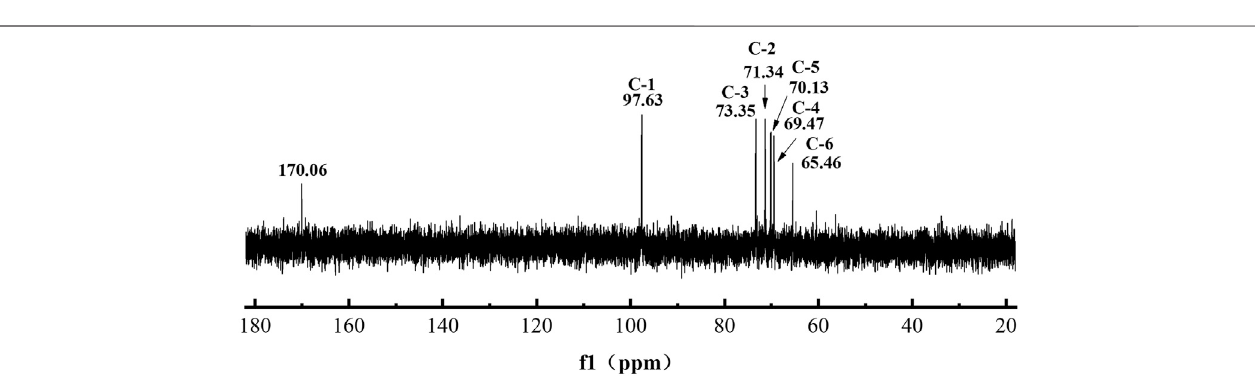
Frontiers in Bioengineering and Biotechnology |